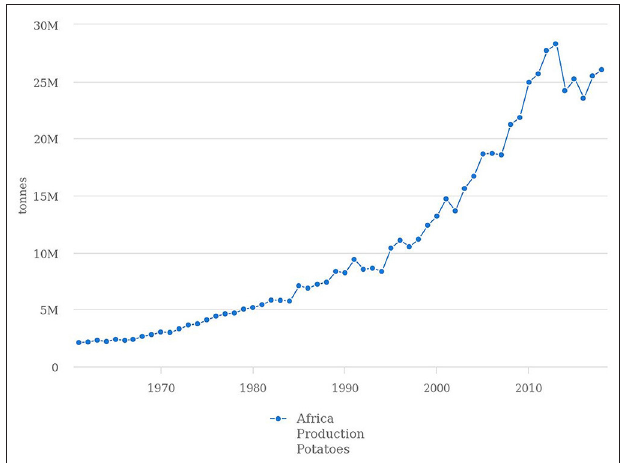
FIGURE 1 | Potato production from 1961–2018, which shows an increased demand over the years. In 2018, 26,041,721 tons of potatoes were produced. The most dramatic change of 90% was realized between 2002 and 2018 ( FAOSTAT,